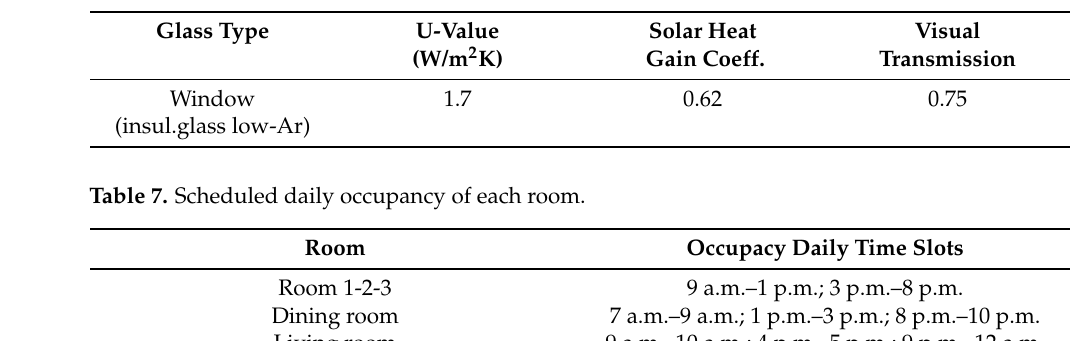
Figure 6. The tri-dimensional model of the building. South-East and North-West view. Table 6. Thermal and optical properties of windows.